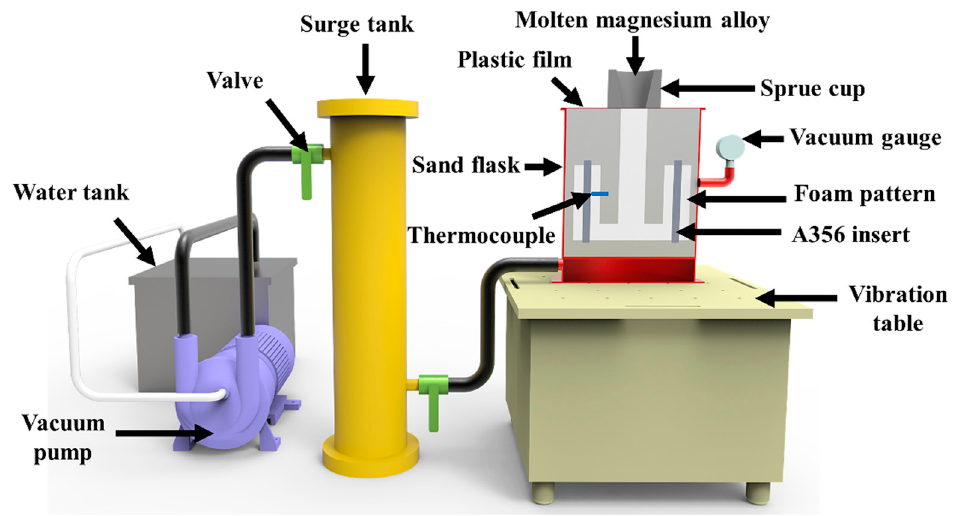
Figure 2. The schematic diagram of the experiment.